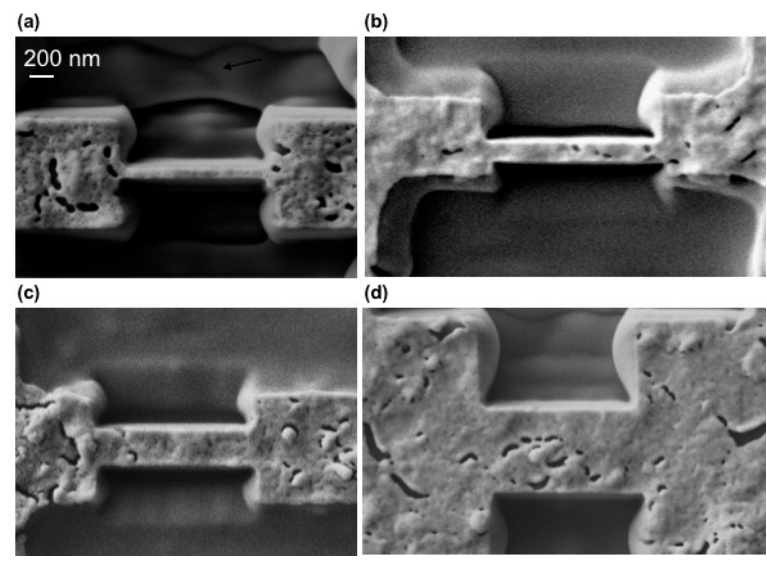
Figure 2. SEM images of patterned nanowires width ( a ) w = 80 nm, ( b ) w = 250 nm, ( c ) w = 300 nm, and ( d ) w = 700 nm.